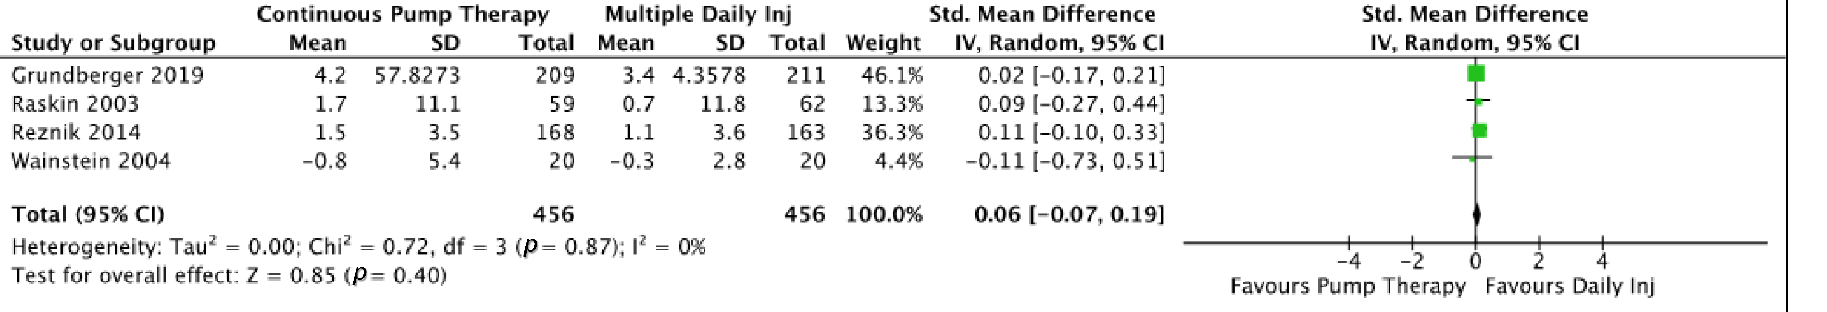
Figure 5. Meta-analysis results and Forest plot for Fasting Plasma Glucose.